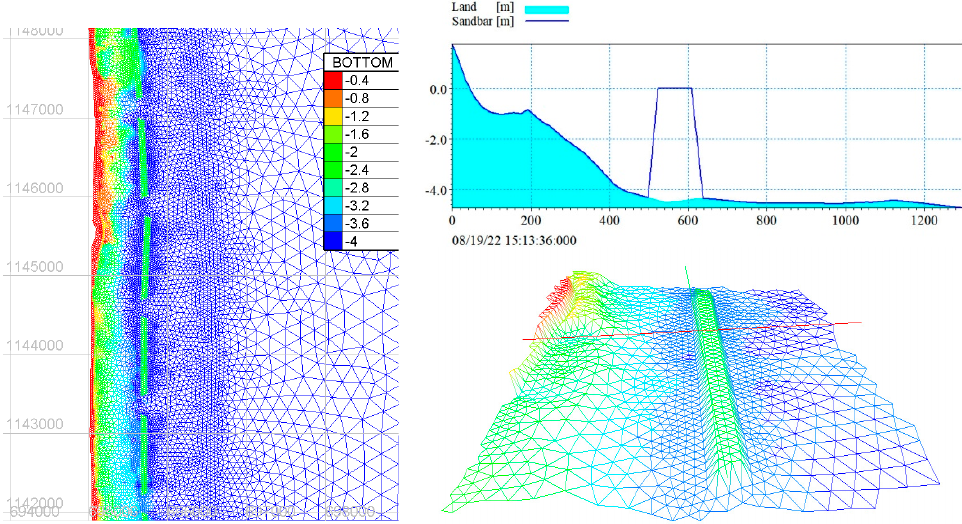
Figure 17. Sandbars along the coast and the view of a sandbar segment in the computation mesh.